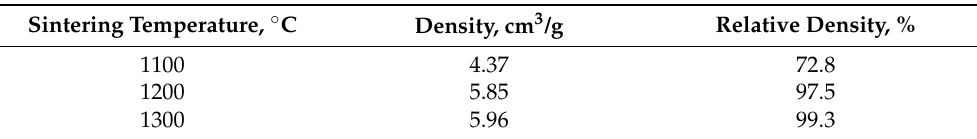
Table 4. The density and the relative density of 2 wt% CaO-ZrO 2 ceramic of a baddeleyite origin sintered at different temperatures.